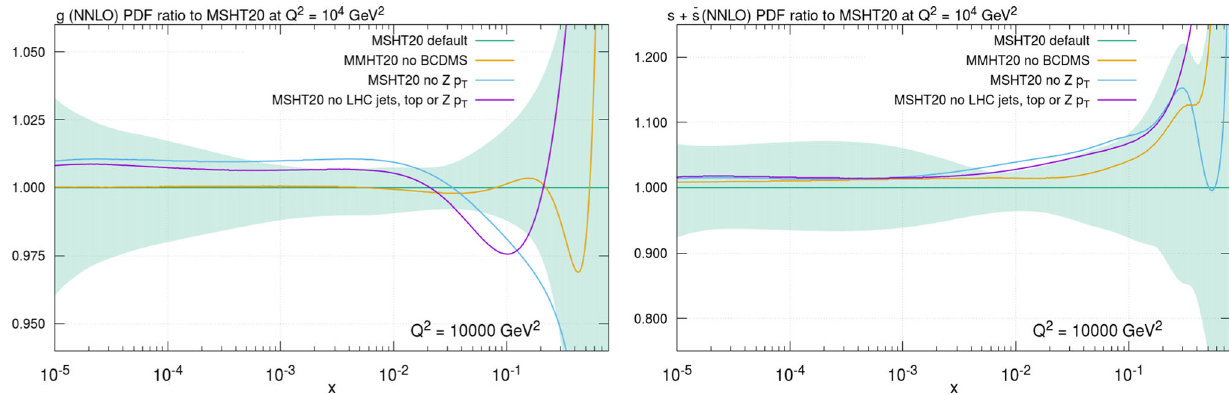
Fig. 80 The MSHT20 (left) gluon and (right) s + ¯ s PDFs at NNLO and Q 2 = 10 4 GeV 2 , compared to the same fit upon removal of the BCDMS data, removal of the ATLAS 8 TeV Z p T data and removal of the LHC jets, top and Z p T